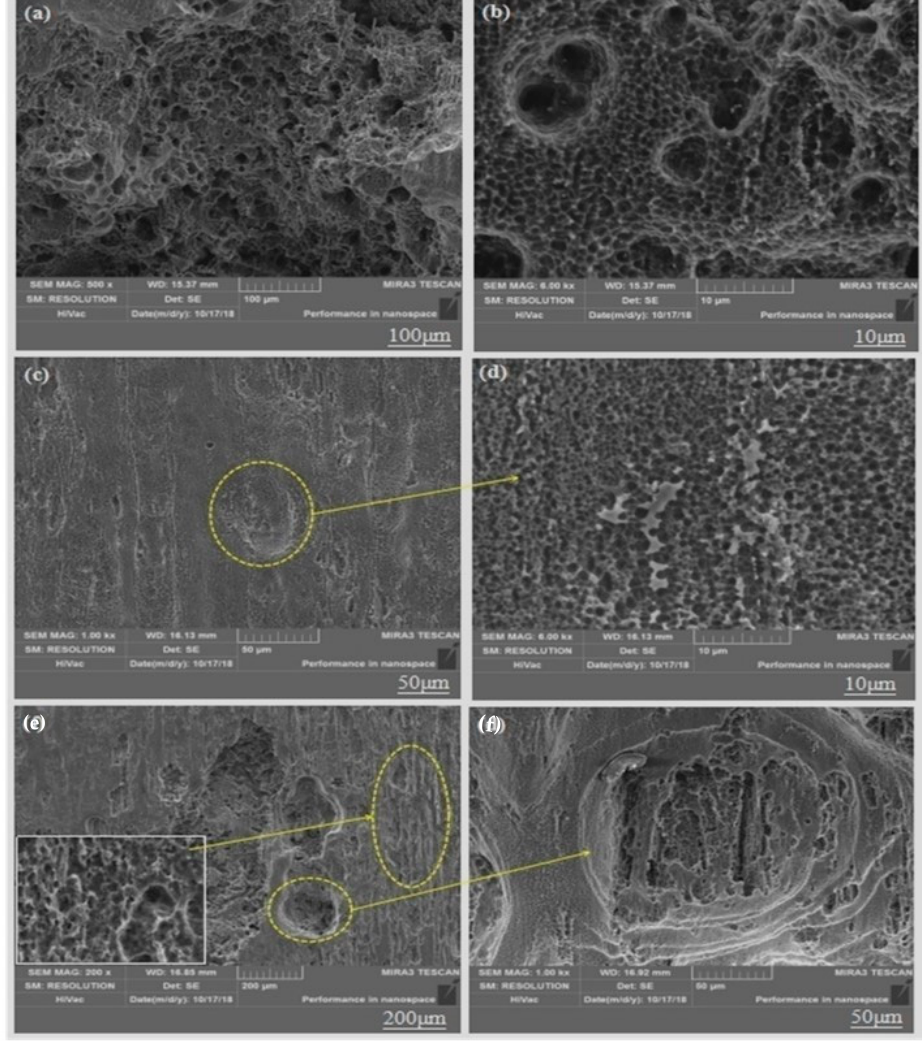
Figure 13. SEM image of surface morphology of alloys removed from corrosion products: ( a , b ) 250 ◦ C; ( c , d ) 300 ◦ C; ( e , f ) 350 ◦